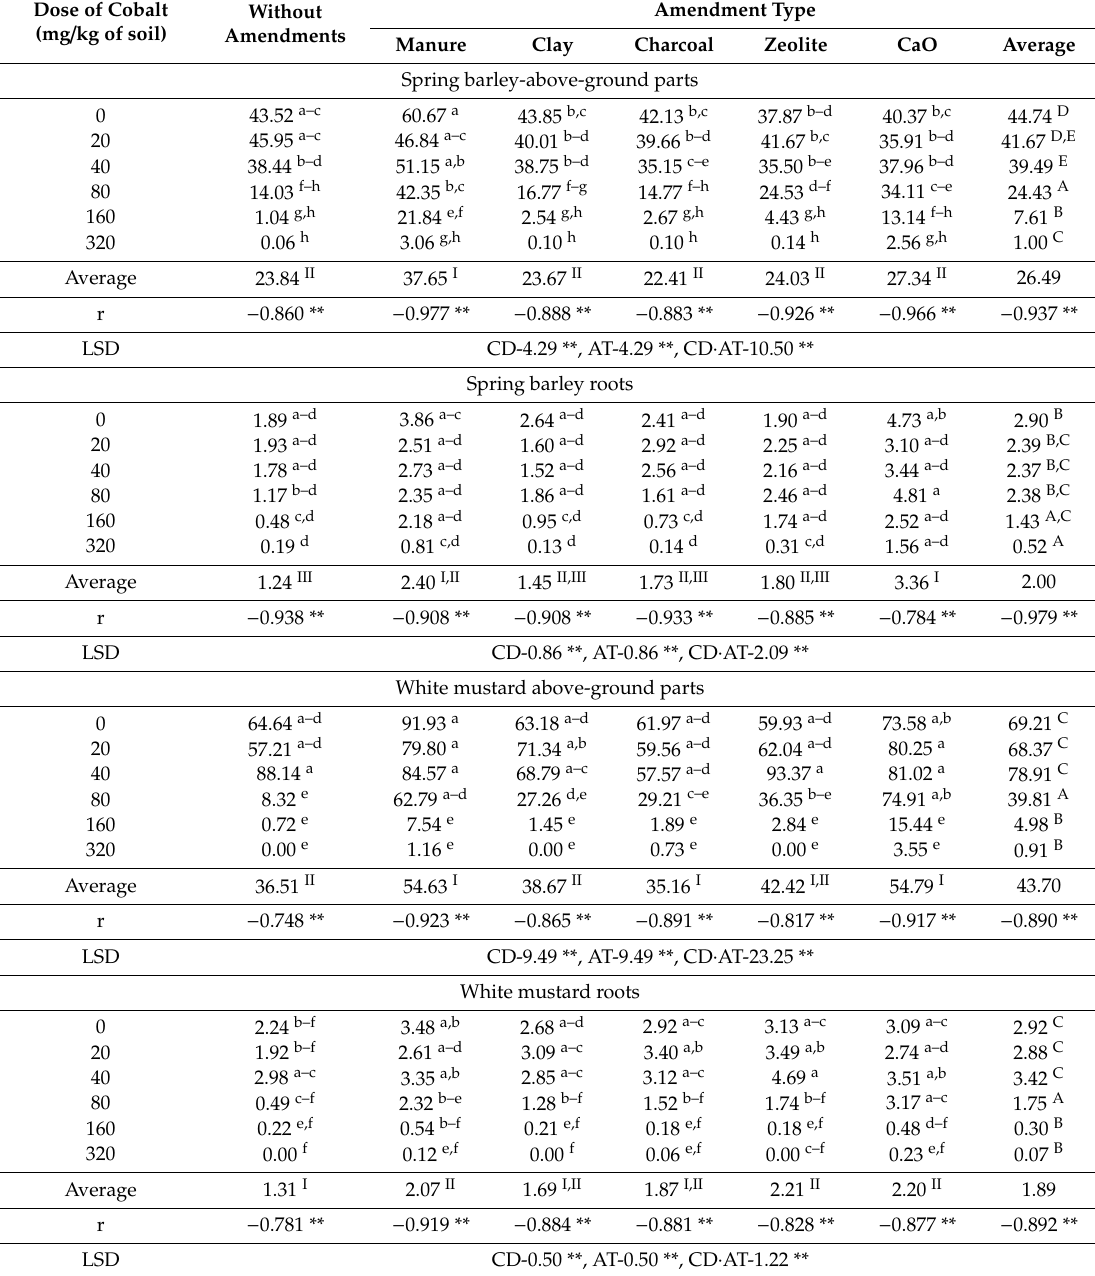
Table 3. Yield of above-ground parts and mass of roots of spring barley and white mustard (g FW / pot). Dose of Cobalt (mg / kg of